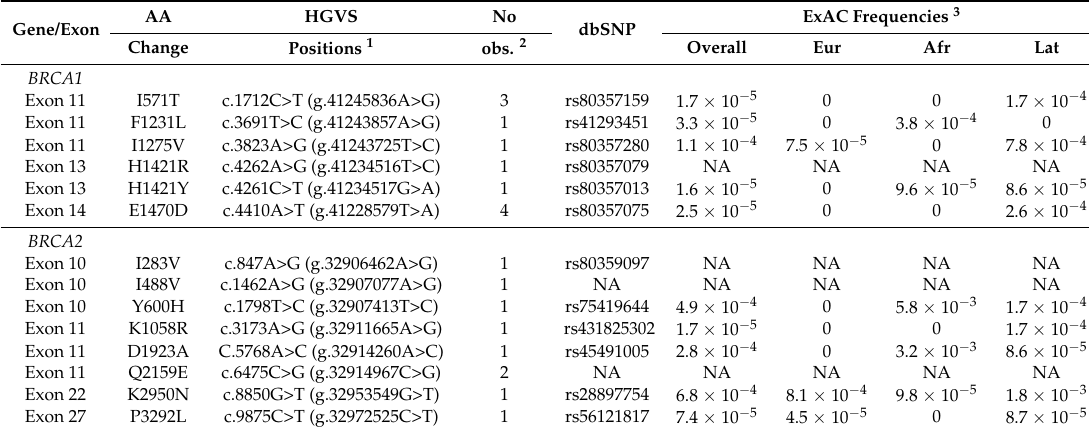
Table 2. BRCA1 and BRCA2 missense variants of uncertain significance detected in Puerto Rican breast cancer